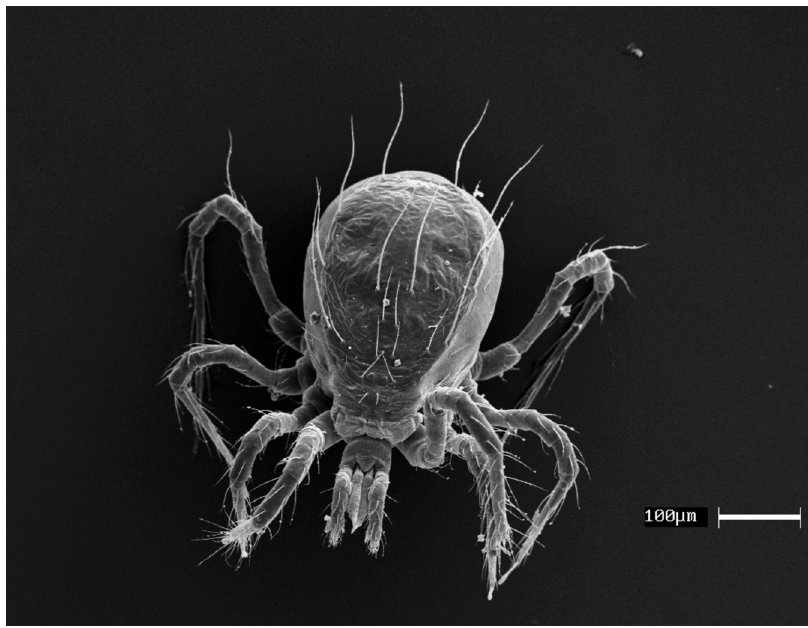
Fig. 13. Dorsal view of Phyto- seiulus persimilis (Athias-